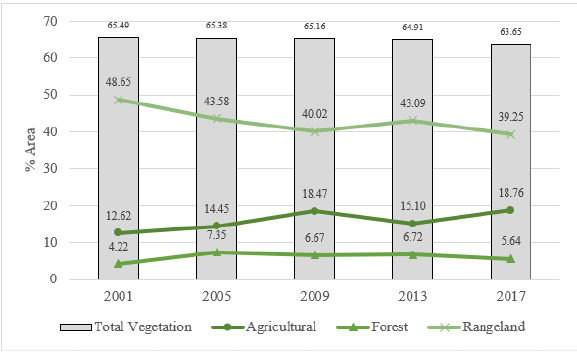
Figure 6. Percent area coverage of built-up, water, and wetland